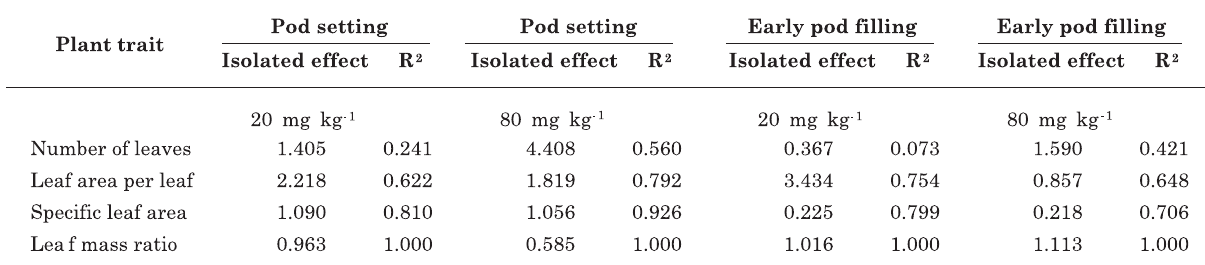
Table 4. Models of stepwise multiple regression analysis, considering total plant dry mass as dependent variable and leaf traits as independent variables, for 24 common bean genotypes grown at two P level applied to the soil (20 and 80 mg kg -1 of P) at two growth stages (pod setting and early pod